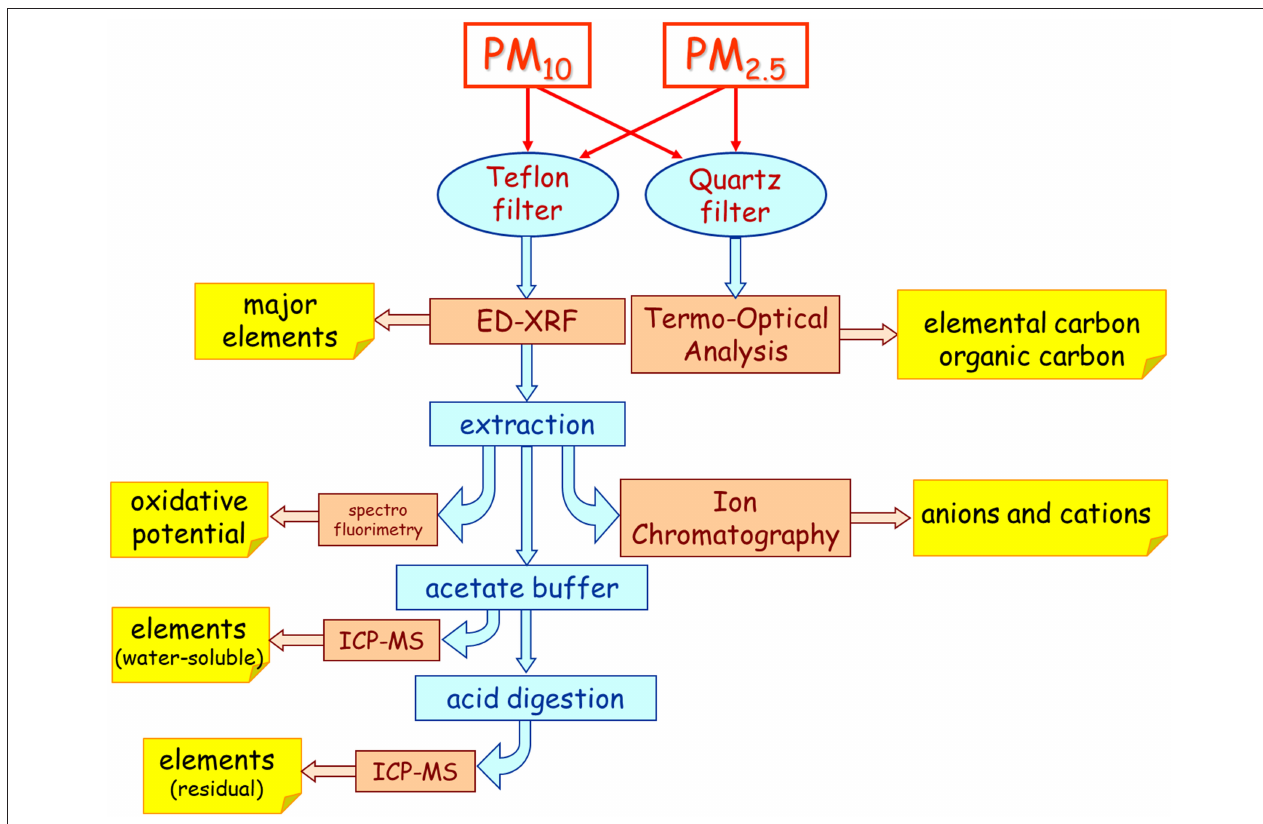
FIGURE 2 | Schematic diagram of the analytical procedure for determining elements, ions, elemental carbon, organic carbon, oxidative